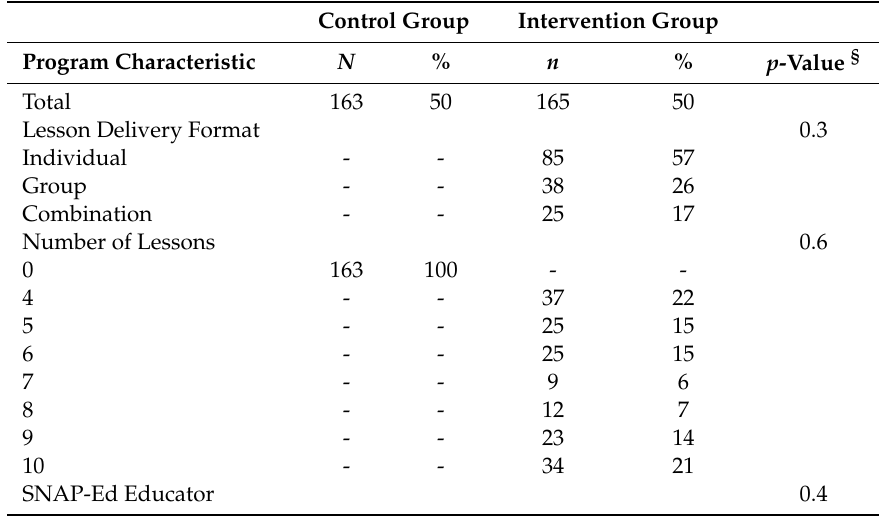
Table 4. Evaluation of lesson delivery format, SNAP-Ed educator, and number of lessons received by Indiana SNAP-Ed Study participants on change in food security score over one year study period using mixed multiple linear regression